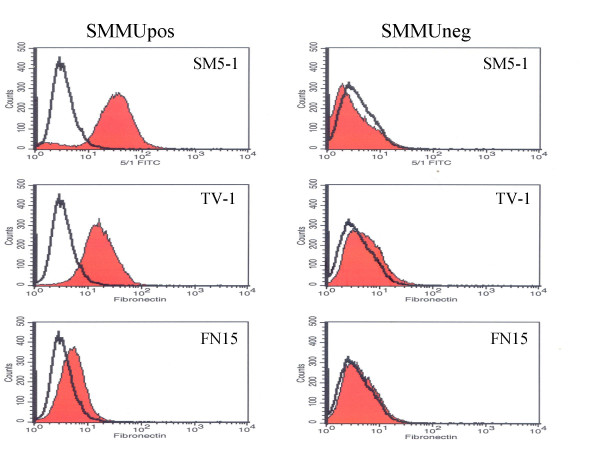
FACS analyses with SM5-1 and Fibronectin antibodies. SMMUpos cells react with mAb SM5-1 and the fibronectin mAbs TV-15 and FN15 while SMMUneg cells are negative for all mAbs.